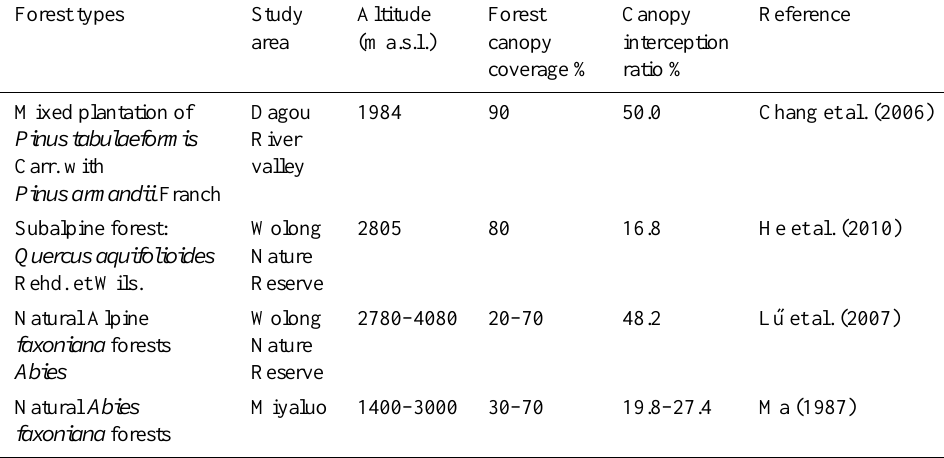
Table 1. Canopy interception of different forest types in the Minjiang River watershed. Forest types Study Altitude Forest Canopy Reference area (ma.s.l.) canopy interception coverage % ratio % Mixed plantation of Dagou 1984 90 50.0 Chang et al. (2006) Pinus tabulaeformis River Carr. with valley Subalpine forest: Nature Reserve Natural Alpine Wolong faxoniana forests Nature Abies Reserve Natural Abies Miyaluo faxoniana